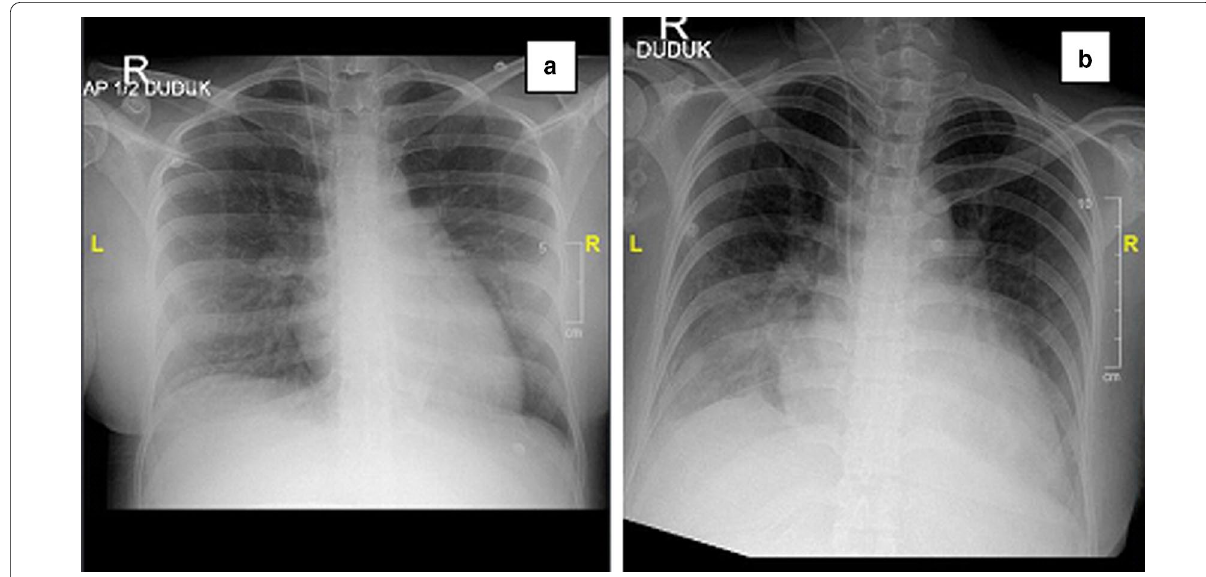
Fig. 1 Thorax X-ray during the third day a compared to the seventh day b showed progression from pulmonary hypertension to cardiomegaly and pulmonary